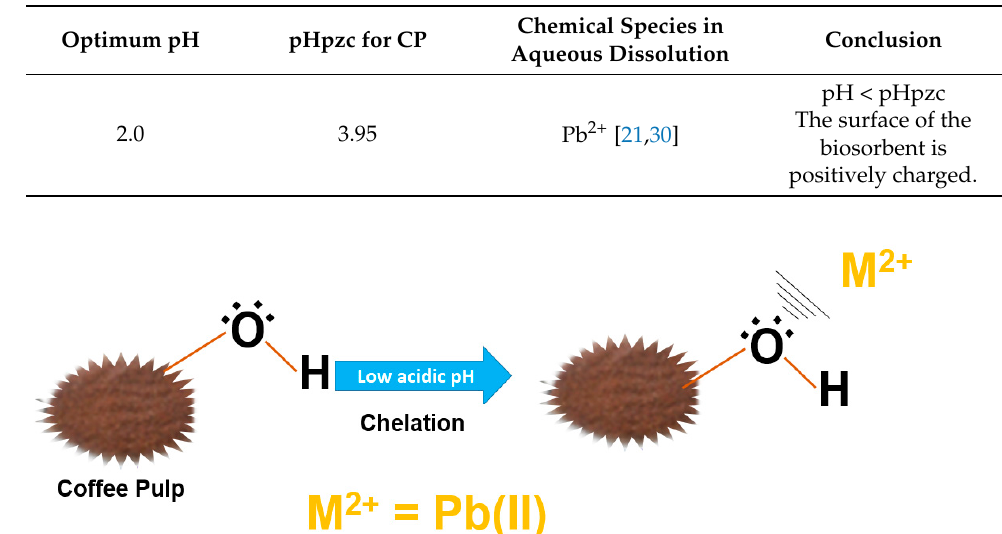
Table 6. pHpzc for the CP and its relation to the optimum pH.